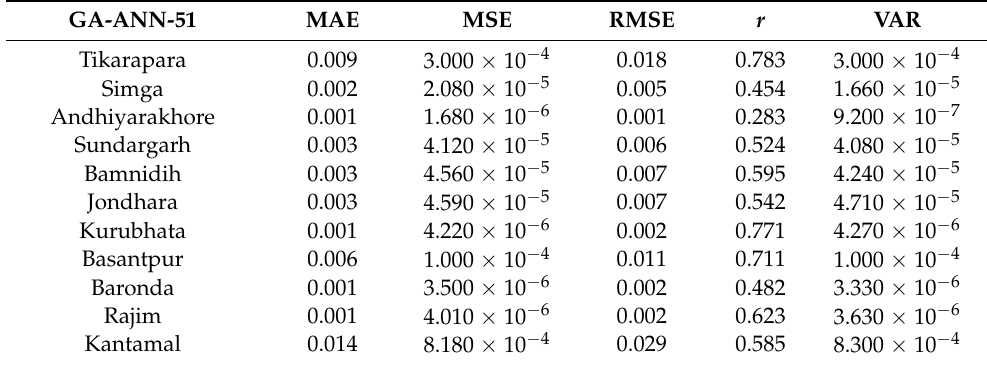
Table 7. Performances evaluation of the proposed best GA-ANN-51 forecasting model at each gauging station during testing phase.